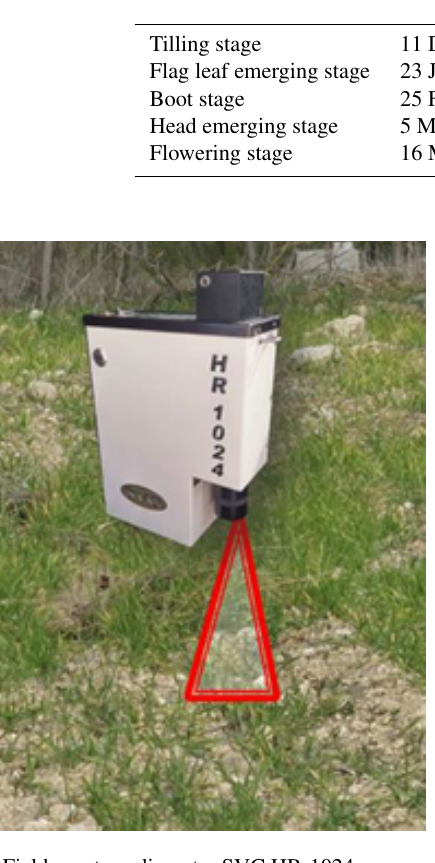
Figure 3. Field spectroradiometer SVC HR-1024.